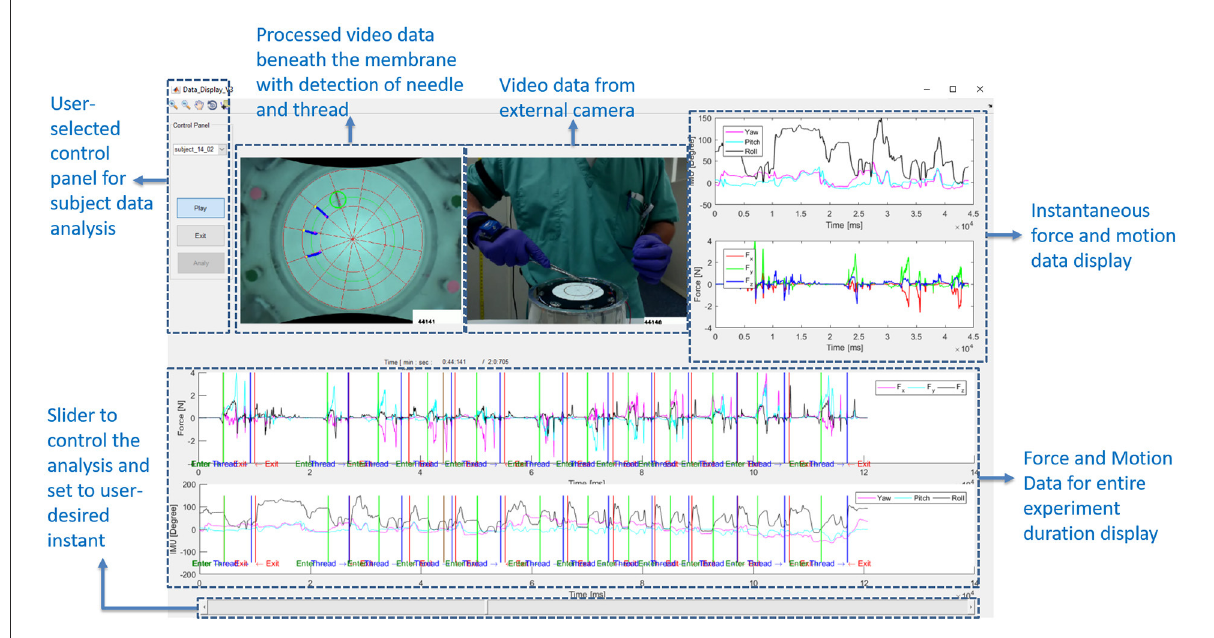
FIGURE5 Graphical User Interface (GUI) designed to show the synchronized force and motion data, along with videos from external and internal cameras. GUI allows for convenient, interactive investigation of synchronized data.